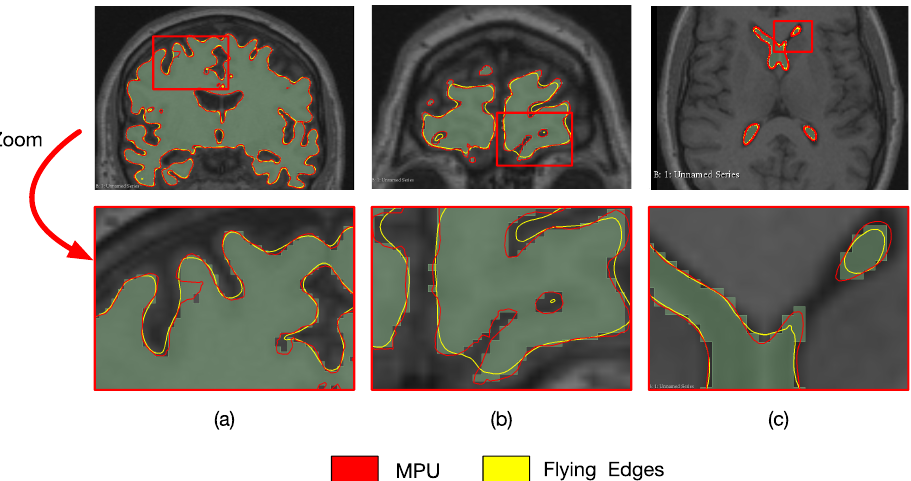
Figure 2. FE and MPU: ( a ) The region of the FE grid processed at the end of the second stage; on the right side is a metadata array describing the interaction of the isosurface with the grid edges. ( b ) Principle of MPU. Top: Two local approximations (dashed red curves) blended to form the global MPU function (solid green curve). Bottom: (1–2) quadric functions are used to approximate the local shape; (1) bivariate quadric is used; (2) general 3D quadric is used; (3) the local function’s error is evaluated in each step of the algorithm in order to determine if the local function has to be refined.